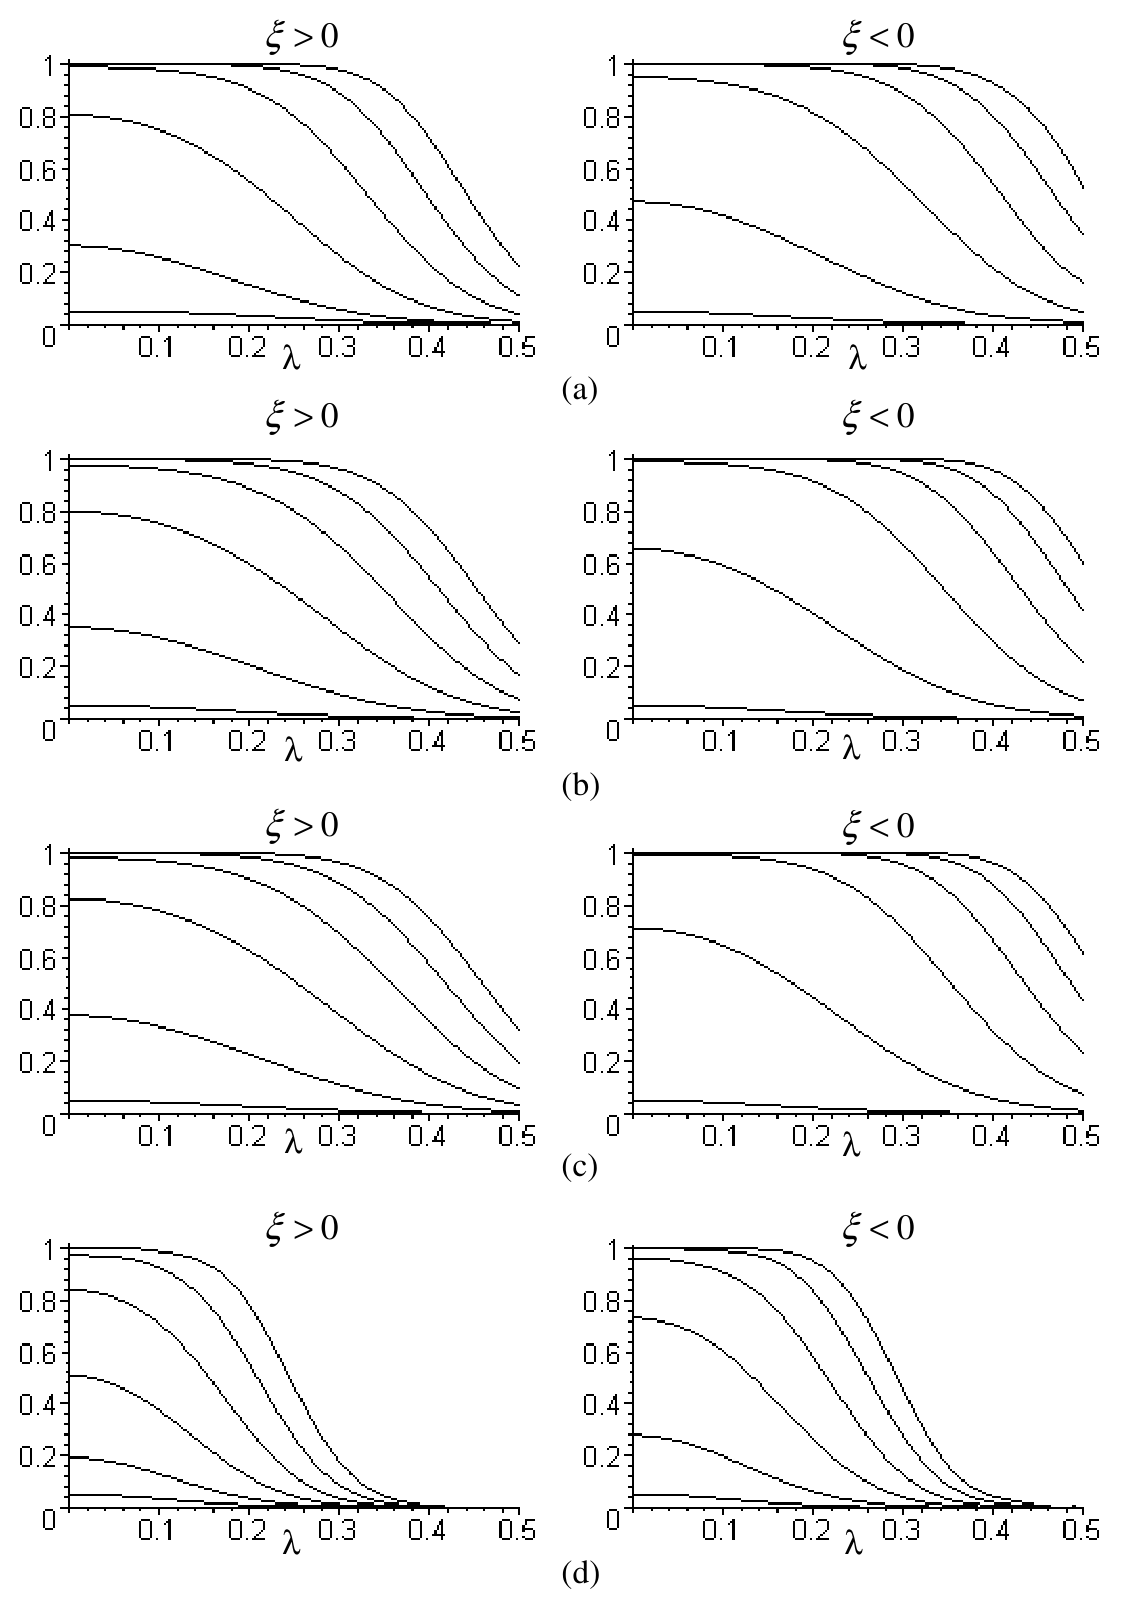
Fig. 2. Plots of π G versus λ with u = 0 . 5, v = 1 . 2, δ = 0 . 3, r = 1, N = 50, α = 0 . 05, C (cid:2)(cid:2) p ( u, v ) = c (0.20)( c + 1) (bottom to top) for (a) c = 1 and C (cid:2)(cid:2) p = C (cid:2)(cid:2) p ( u, v ); (b) c = 1 and C (cid:2)(cid:2) p = C (cid:2)(cid:2) p ( u, v ) + 0 . 33; (c) c = 1 and C (cid:2)(cid:2) p = C (cid:2)(cid:2) p ( u, v ) + 0 . 5; (d) c = 1 . 5 and C (cid:2)(cid:2) C (cid:2)(cid:2) u, v ); (e) c = 1 . 5 and C (cid:2)(cid:2) C (cid:2)(cid:2) u, v ) + 0 . 33; (f) c = 1 . 5 and C (cid:2)(cid:2) p = p ( p = p (